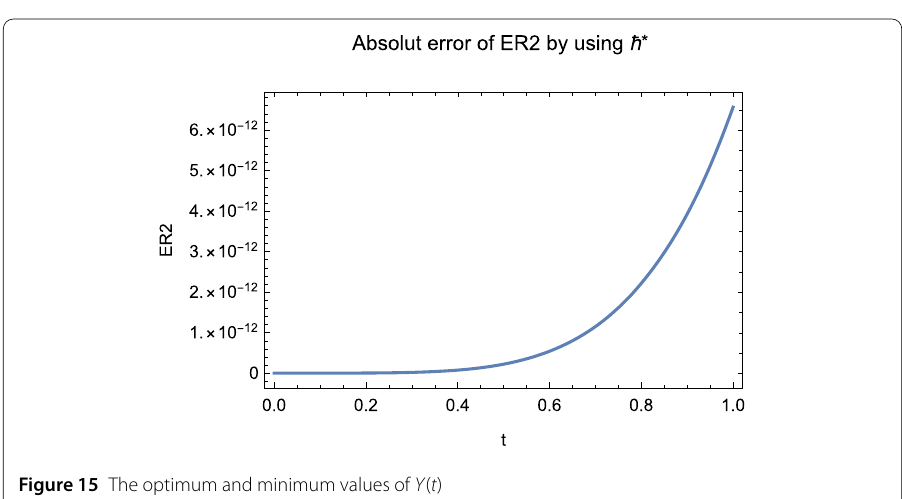
Figure 15 The optimum and minimum values of Y ( t )